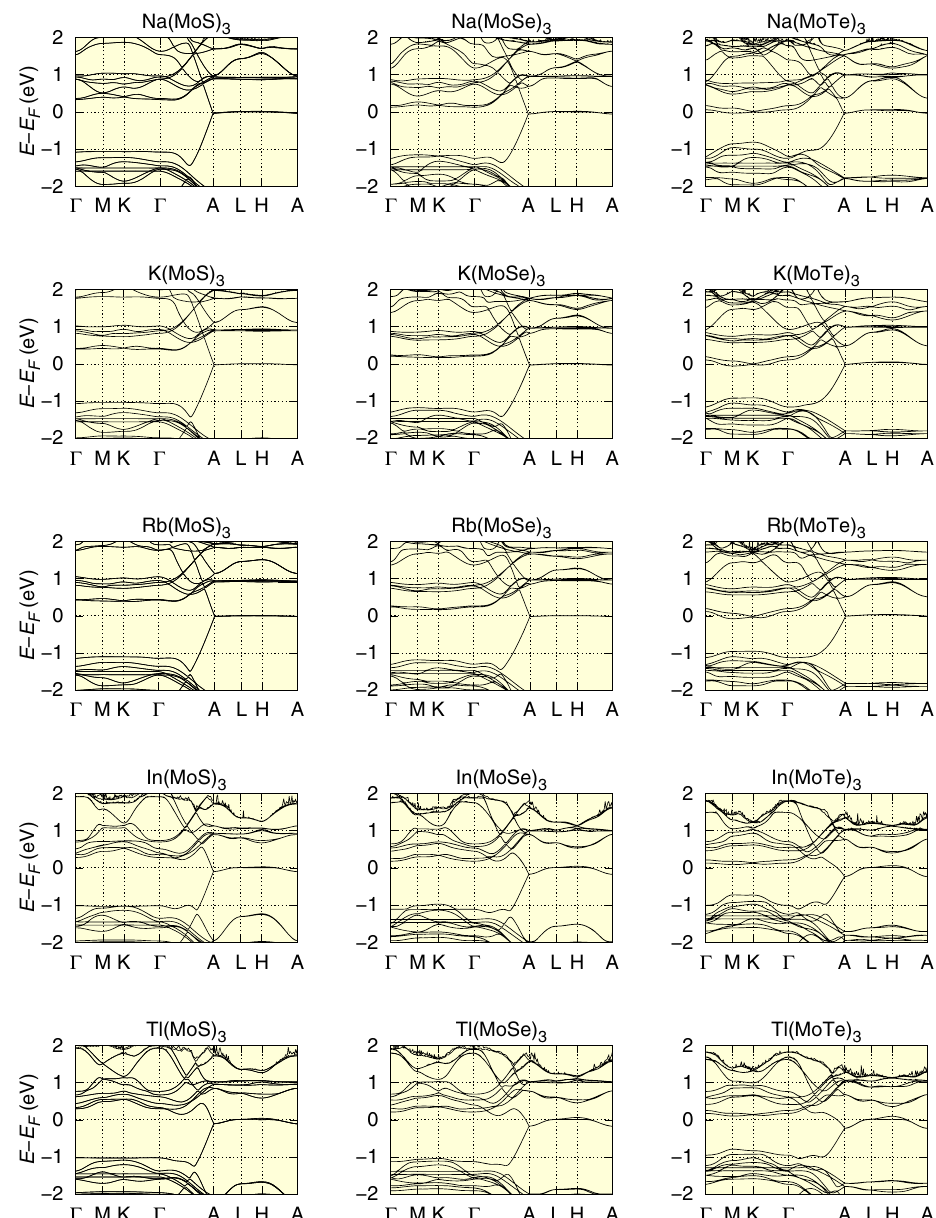
FIG. 7. Band structure of 15 A ð MoX Þ 3 compounds with undistorted P 6 3 = m